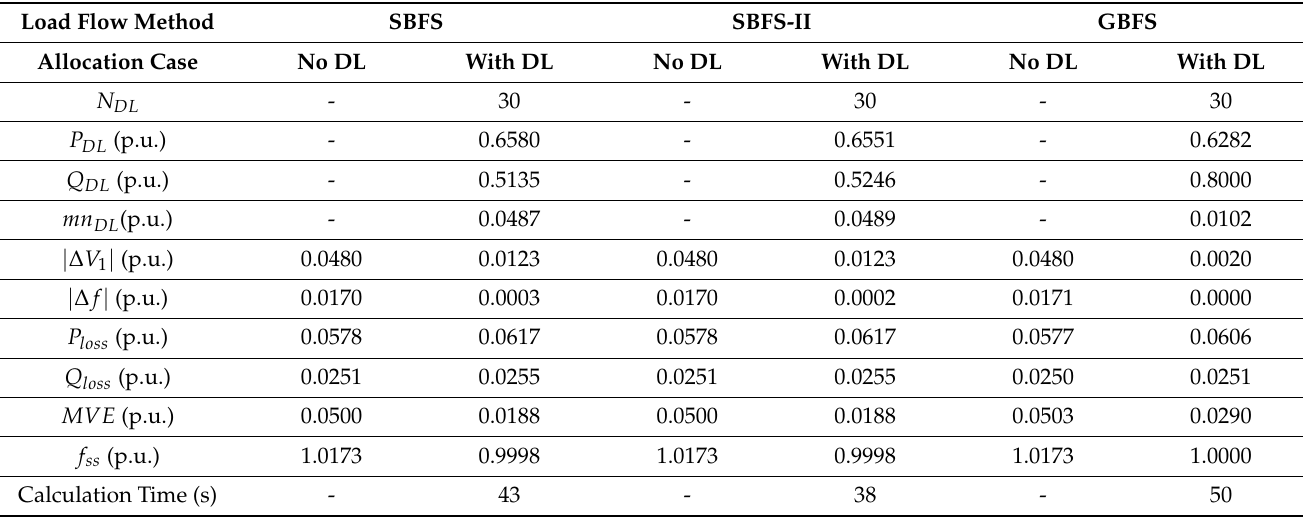
Table 8. Multi-objective results with different load flow methods for the 69-bus